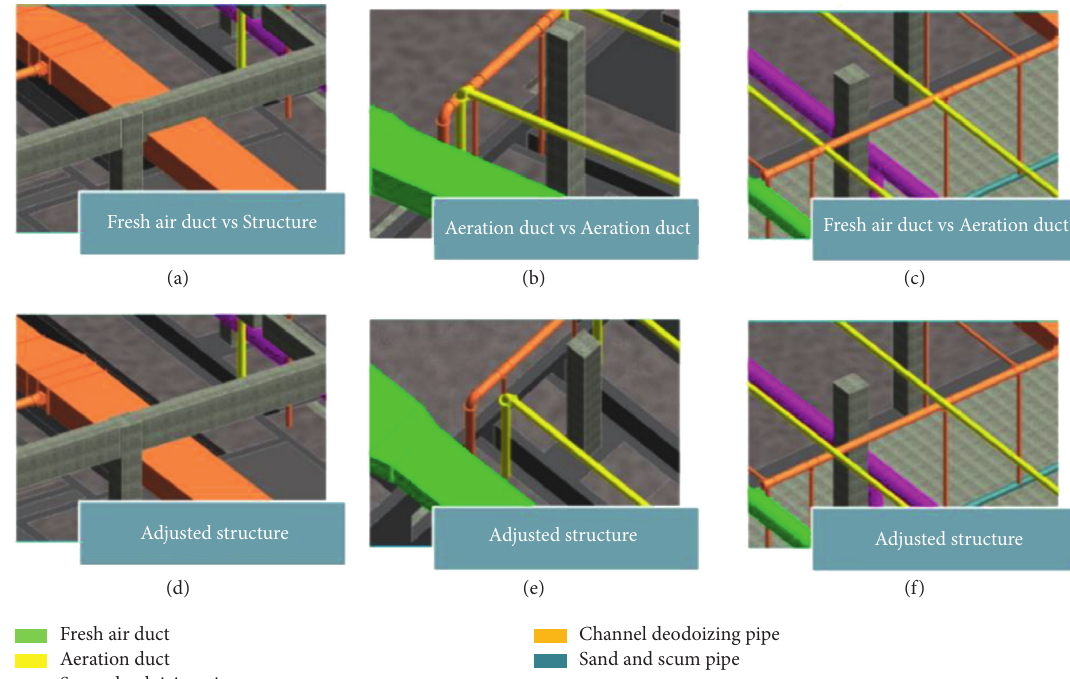
Figure 2: Interference checking and comparison with adjusted